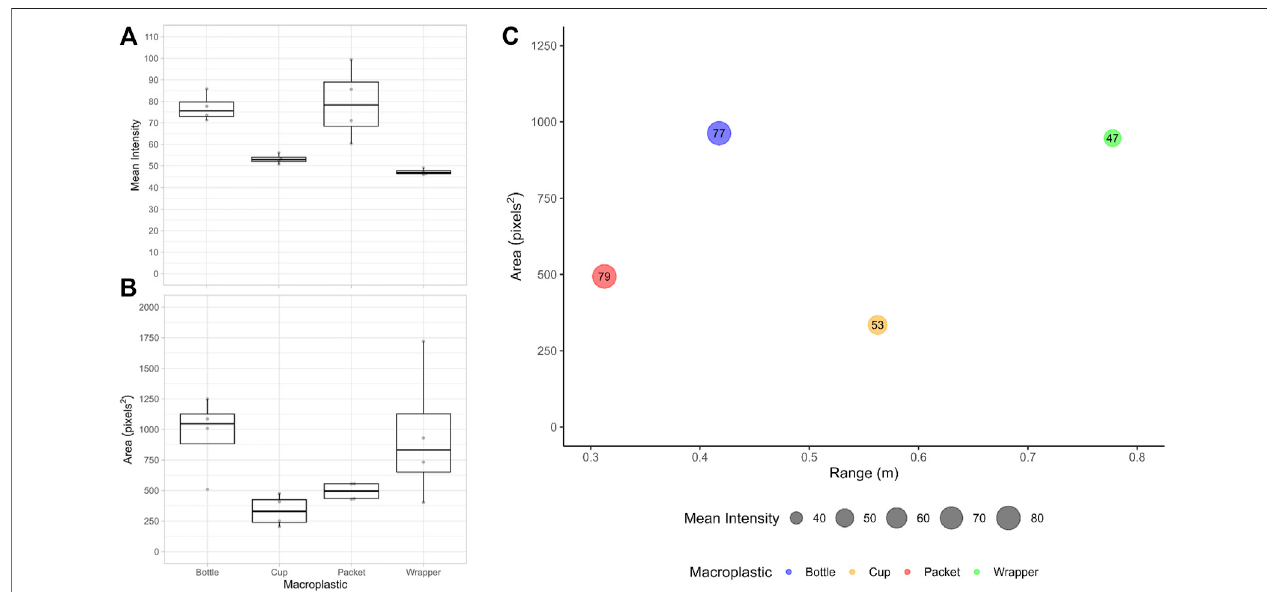
FIGURE 4 | Box plots of (A) the mean intensity and (B) the area of the macroplastic ( n = 4) re fl ections from the SSS images as detected in standing water. The center lines represent the median values, the edges of the boxes the fi rst and third quartiles, the whiskers the minimum and maximum, and the underlying data points appear ingrey. (C) Uniquemeanre fl ectionsforeachtype ofmacroplastic givenbythemeanarea(y-axis) andmeanintensity(bubble sizes/values)atmeanrange(x-axis) for the SSS images as detected in standing water.